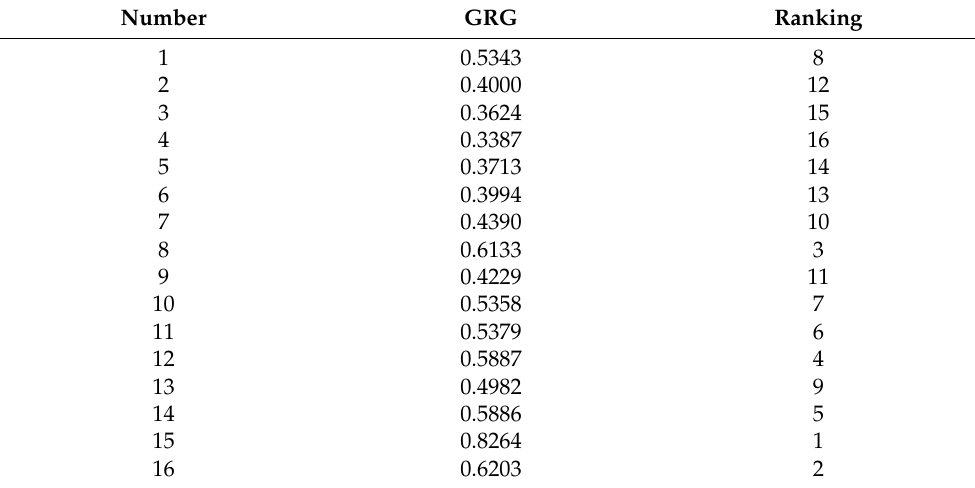
Table 7. The GRG and ranking of experimental results.